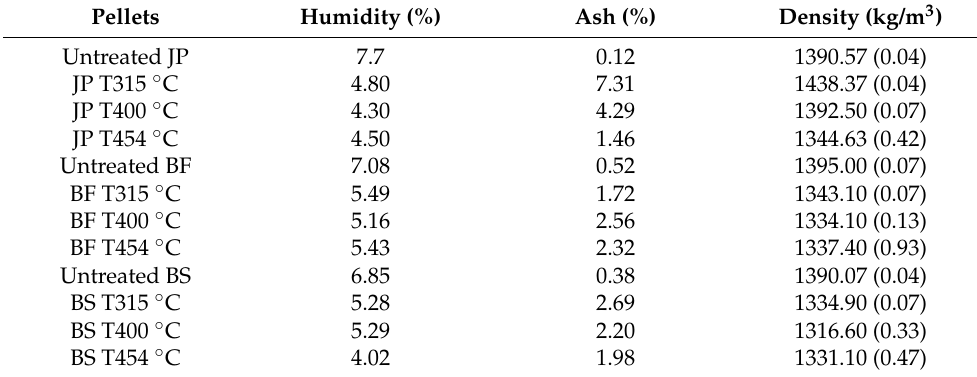
Table 4. Physical properties of